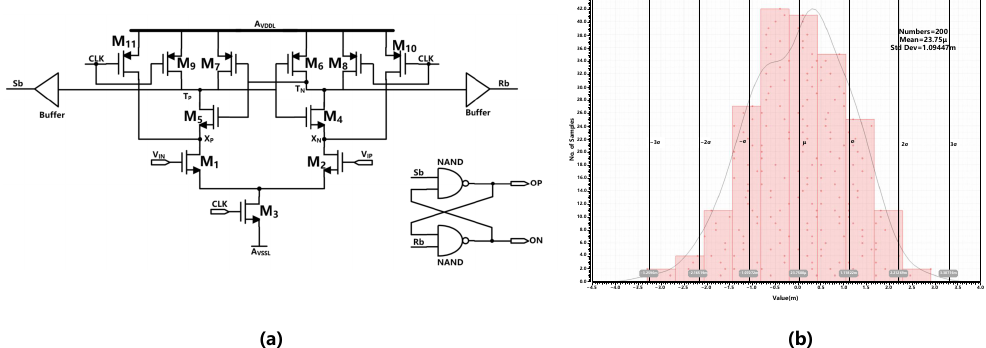
Figure 16. ( a ) Schematic of the comparator. ( b ) The Monte Carlo simulation result of the compara- tor’s